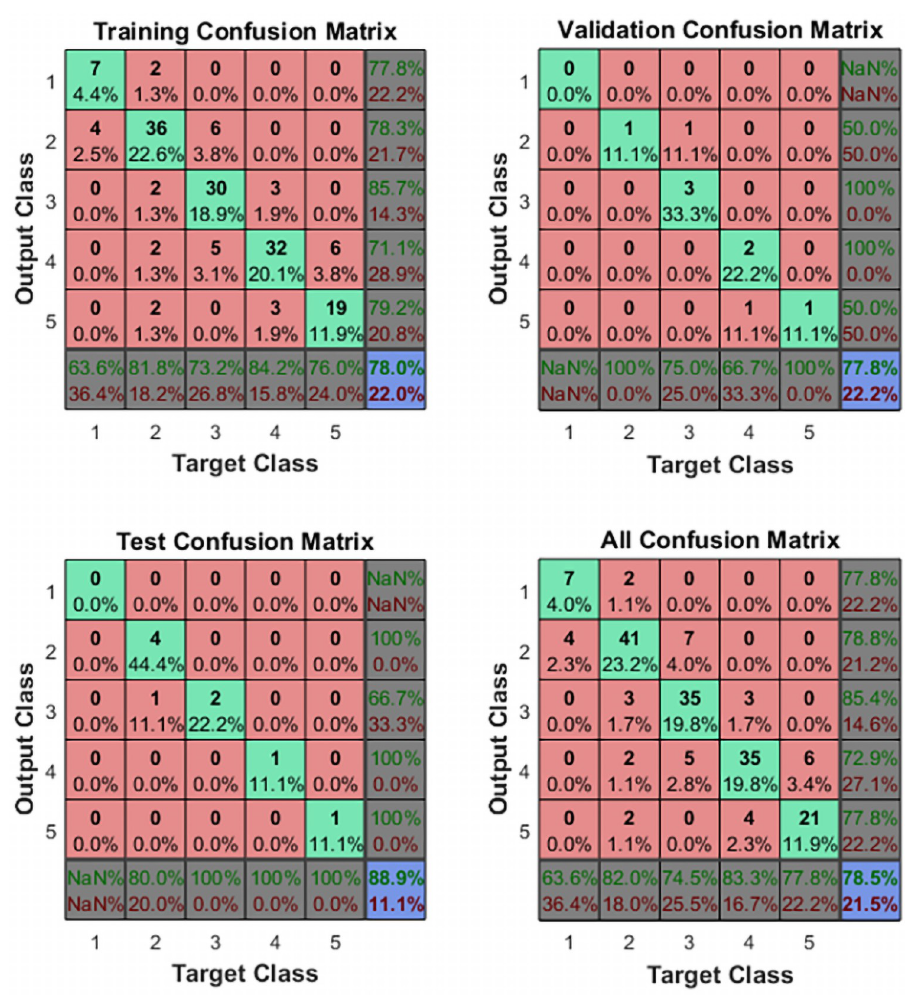
Fig 22. Results of artificial neural networks